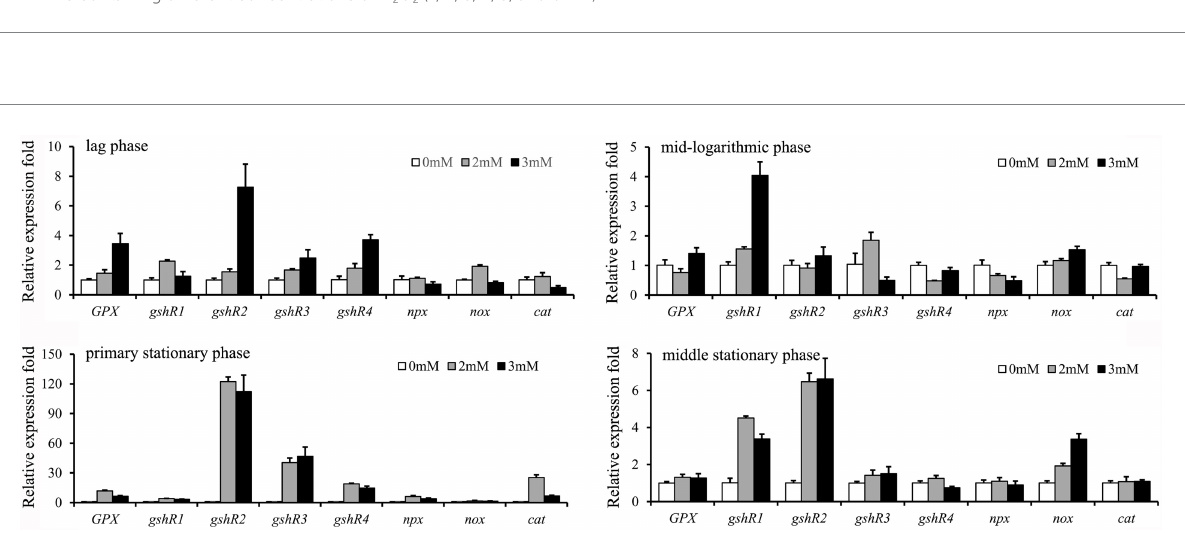
FIGURE 2 Effects of the addition of hydrogen peroxide on the expression of 8 antioxidant-related genes in Lactobacillus plantarum GXL94. The graphs show the relative mRNA levels of 8 genes of cells grown in MRS medium with different concentrations of hydrogen peroxide at the lag phase, mid- logarithmic phase, primary stationary phase and middle stationary